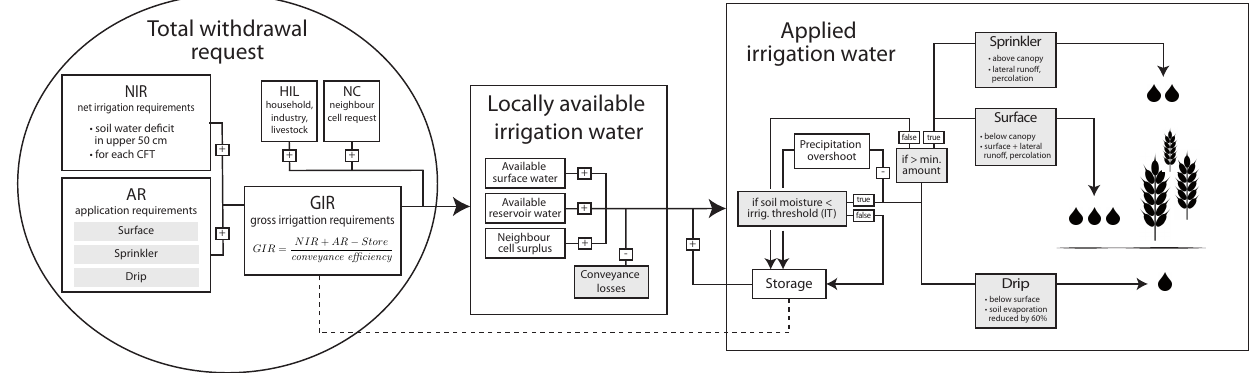
Figure 2. Irrigation water flows in LPJmL from plant-specific net irrigation requirement to actual field application. Variables represented in grey-shaded boxes depend on system-specific parameters that are presented in Table